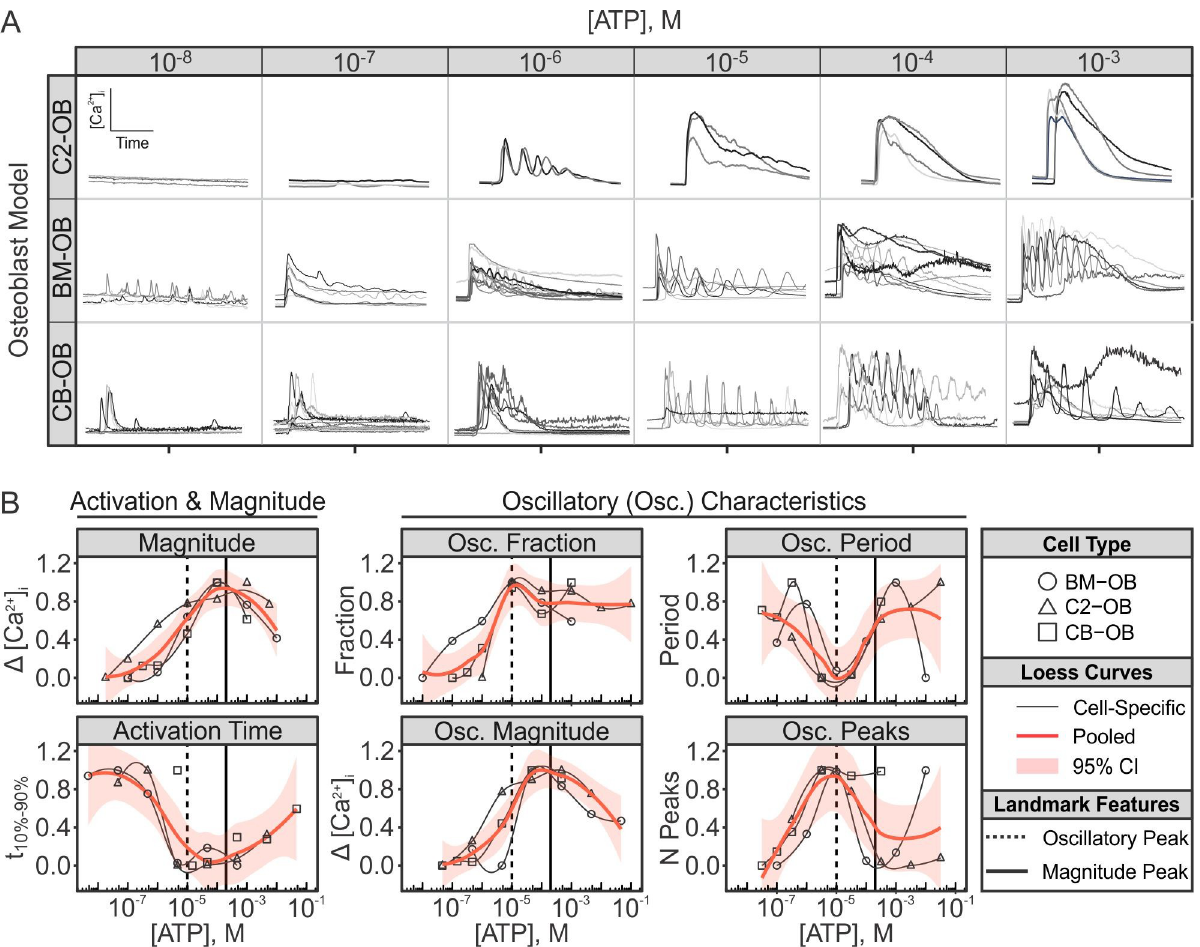
Fig 1. ATP-induced Ca 2+ response characteristics are conserved across murine osteoblast lines. Fura2-loaded BMP2-transfected C2C12 osteoblastic cells (C2-OB), bone-marrow-derived osteoblasts (BM-OB), or compact-bone-derived osteoblasts (CB-OB) were stimulated with ATP (10 − 8 to 10 − 3 M), changes in [Ca 2+ ] i were recorded, and characteristic parameters of individual cell-level Ca 2+ responses were quantified. ( A ) Representative ATP-induced Ca 2+ signature responses for different osteoblastic lines. Recording duration : 120 s. ( B ) Activation time, magnitude and oscillatory characteristics of Ca 2+ responses in different osteoblastic cells were aligned to obtain consensus on dose-dependency behaviours (see S1 Fig for intermediary alignment steps). Data are response means, normalized to peak dose-response. Solid curves : Loess curves fit to normalized response means. Vertical solid lines : peak magnitude; Vertical dashed lines : peak oscillatory activity; CI: confidence interval, M: molar concentration.